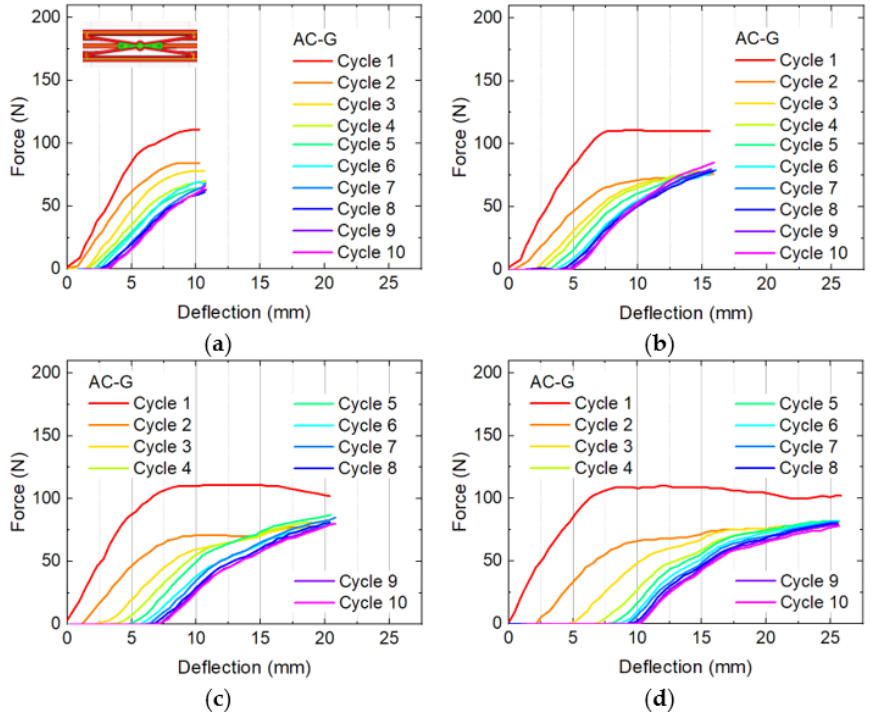
Figure 5. Bending and recovery tests of four AC-G specimens with different maximum deflections: ( a ) 11 mm; ( b ) 16 mm; ( c ) 21 mm; ( d ) 26 mm.